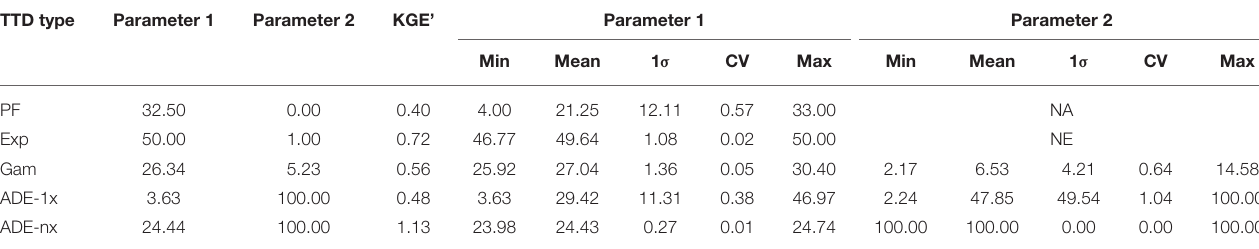
TABLE 1 | Estimated TTD parameters for various TTD types. TTD